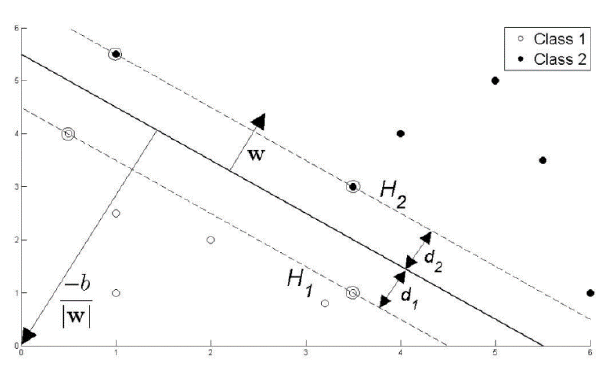
Figure 1: Linear classifier [10] defined by the hyperplane H